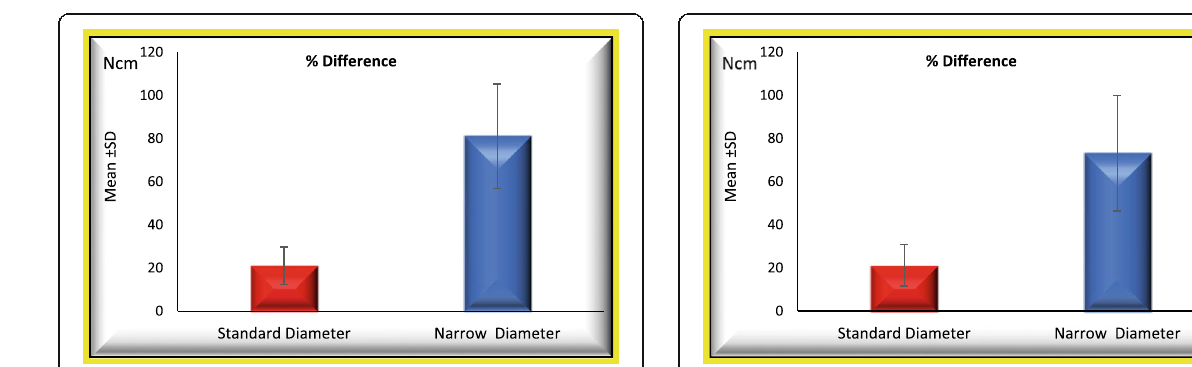
Fig. 5 Mean of percentage difference between initial and post load